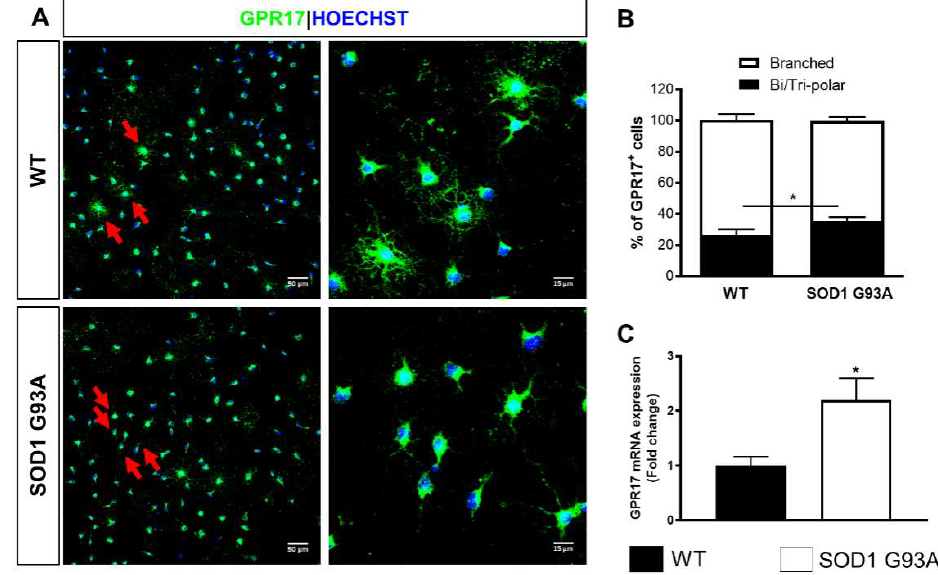
Figure 5. OPCs isolated from P7 SOD1 G93A mice are blocked at immature GPR17 + stage. ( A ) Representative images showing GPR17 + cells in WT and in SOD1 G93A OPC cultures. Insets show higher magnification of representative GPR17 + cells with branched (in WT cultures) or with bi/tripolar morphology (in SOD1 G93A cultures). Arrows indicate GPR17 + cells with highly ramified or bipolar / tripolar morphology. Scale bar: 50–15 µ m. ( B ) Stacked histograms showing the quantification of the bipolar / tripolar and the branched GPR17 + cells. Data are the mean ± SE of cell counts from a total of six coverslips / condition from three experiments. * p < 0.05 SOD1 G93A vs. WT; Student’s t -test. ( C ) Histograms showing GPR17 mRNA level quantification by qRT-PCR in SOD G93A cultures with respect to WT cultures ( n = 3). * p < 0.05 SOD1 G93A vs. WT; Student’s t